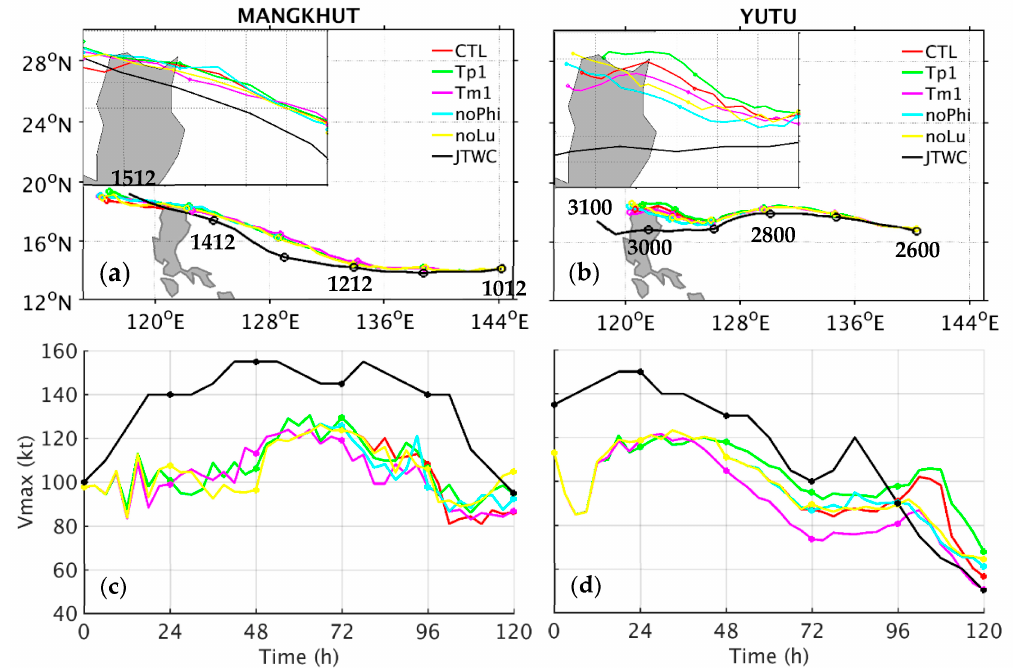
Figure 5. Simulated tracks for ( a ) Mangkhut from 1200 UTC 10 September to 1200 UTC 15 September and ( b ) Yutu from 0000 UTC 26 October to 0000 UTC 31 October. ( c ) and ( d ) are the same as in ( a ) and ( b ), respectively, but for the time evolution for 10 m maximum wind speed (kt). The best track (black line) is from the JTWC. The simulated tracks for CTL, Tp1, Tm1, noPhi, and noLu are shown by red, green, magenta, cyan, and yellow lines, respectively.